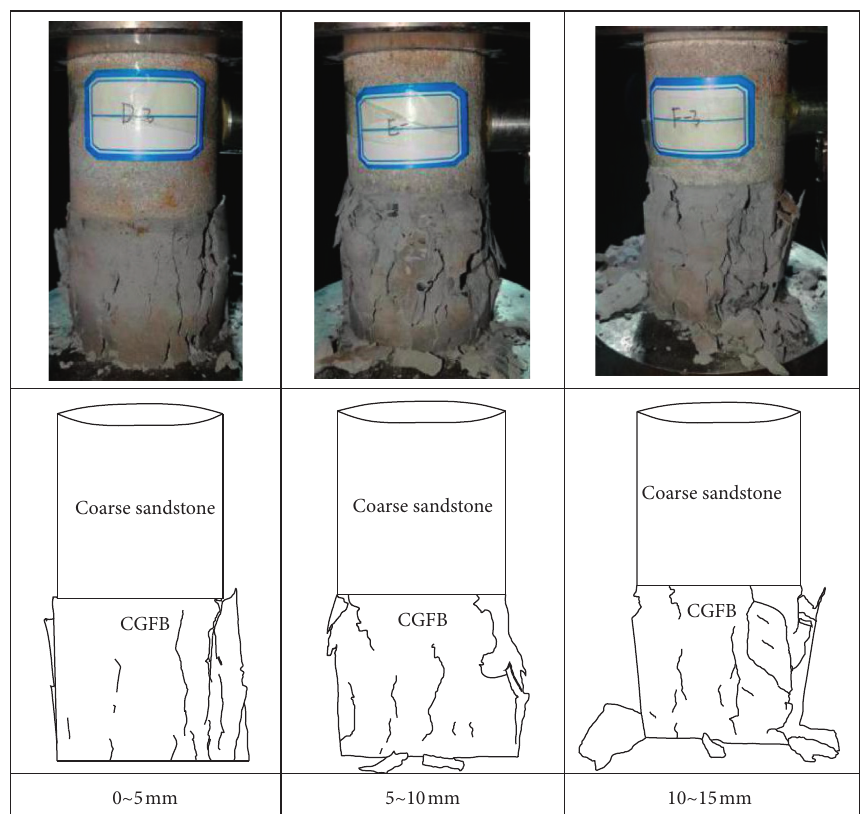
Figure 7: Typical macrofailure patterns of composite